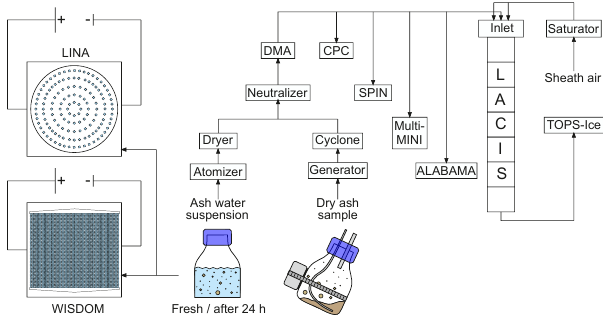
Figure 1. Instrumental setup during the INUIT